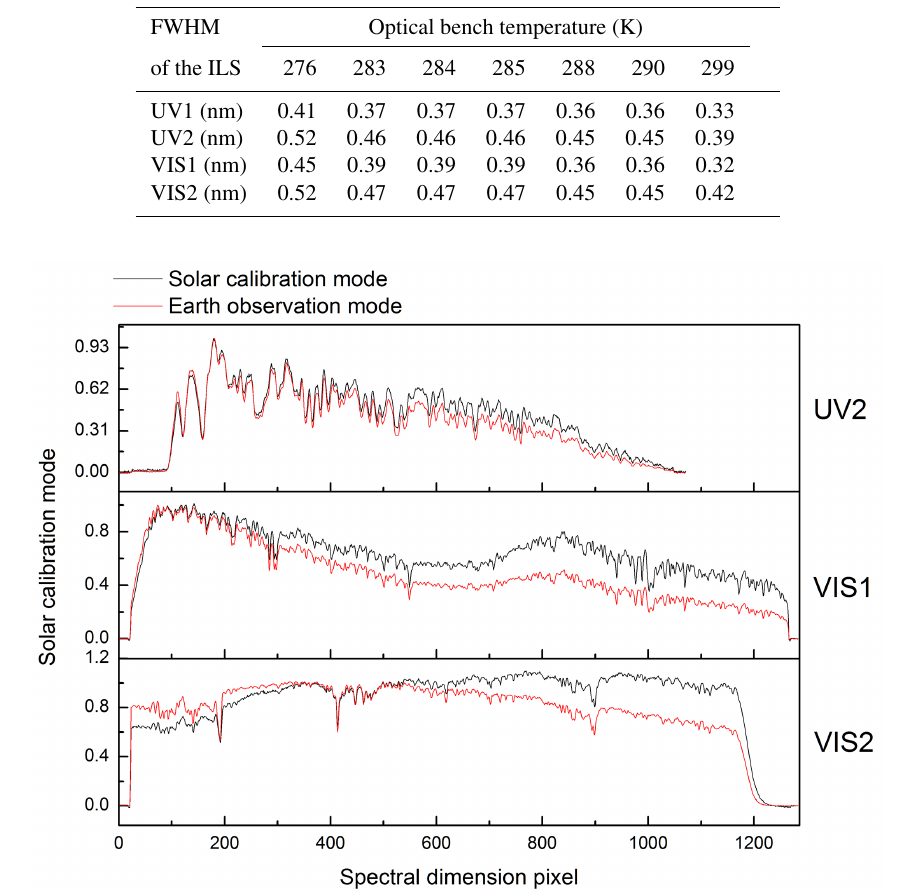
Figure 7. Solar spectrum obtained by the EMI on the ground. The aluminum diffuser is used to observe the solar spectrum in the SCM (Fig.